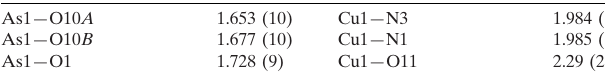
Selected bond lengths (A˚ ).